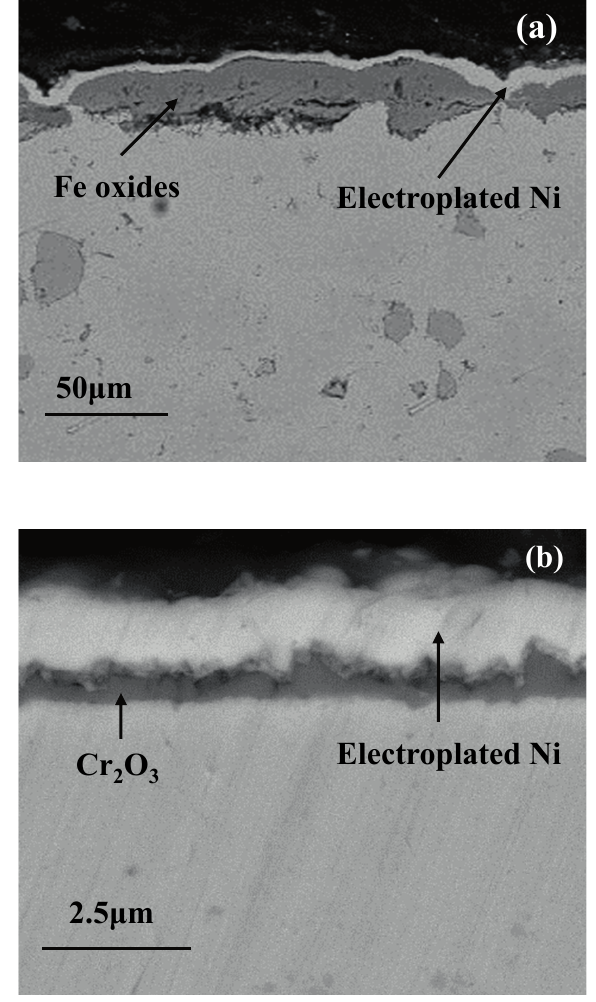
Figure 3. Scale microstructure of PMFe-40Ni-15Cr and MA Fe-40Ni-15Cr alloys oxidized at 1073 K in 1:01 (cid:2) 10 2 kPa pure oxygen for 24 h: (a) PMFe-40Ni-15Cr and (b)